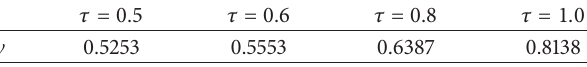
Table 1: Minimum index 𝛾 for different 𝜏